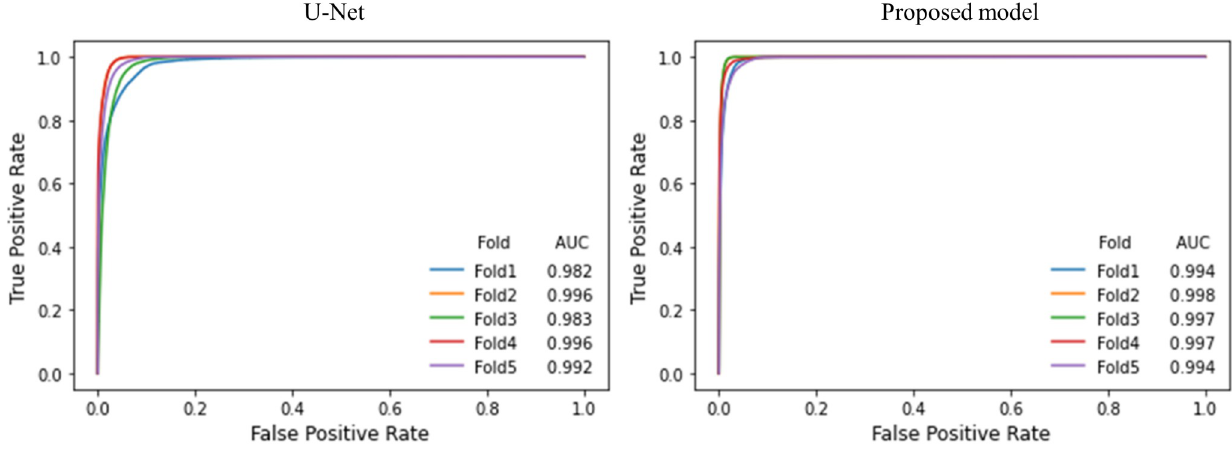
Fig 4. ROC curve analysis. The left and right sections of the image are the ROC curves of U-Net and the proposed model, respectively. ROC, receiver operating characteristic.